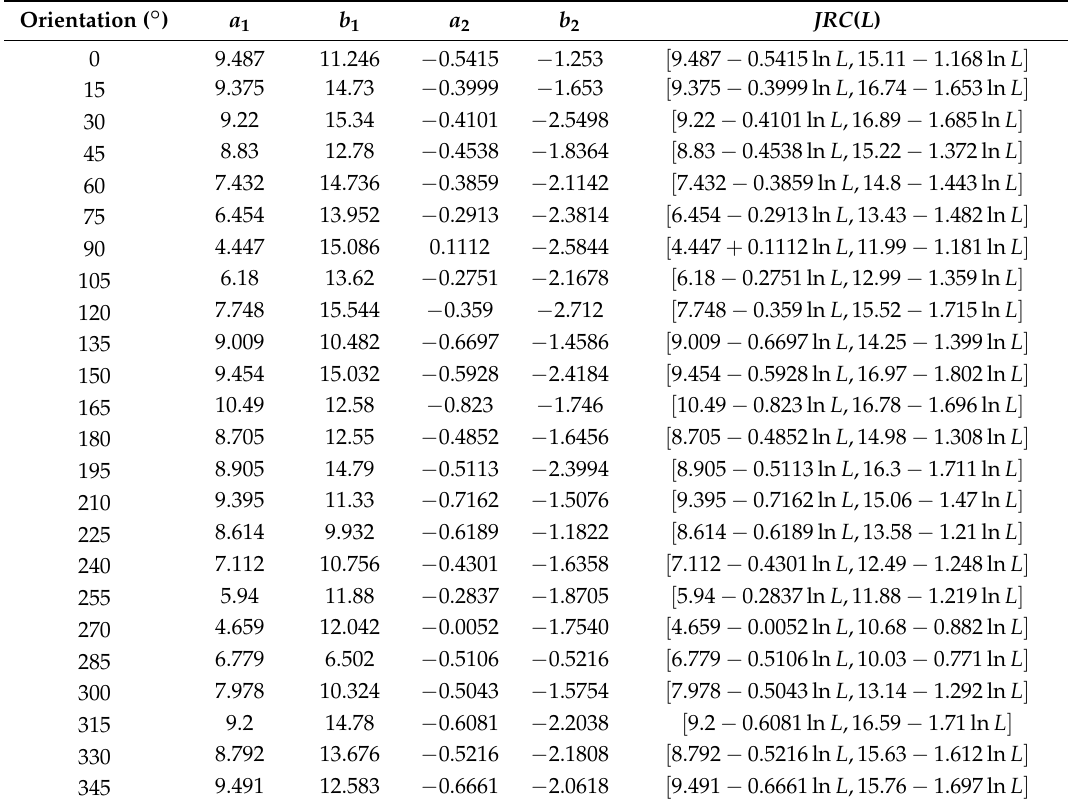
Table 3. NN functions of JRC ( L ) for I (cid:15) [0, 0.5] corresponding to the JRC values of the joint samples in different orientations.